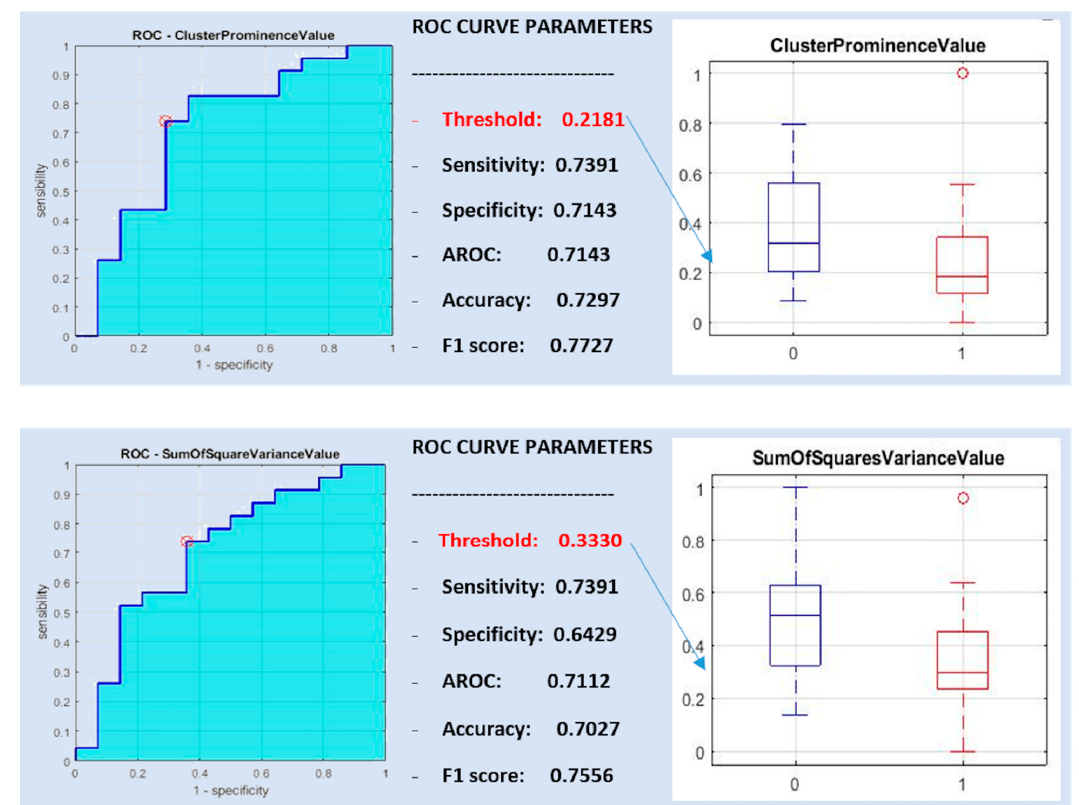
Figure 5. ROC curve analysis for Warthin versus malignant tumors.